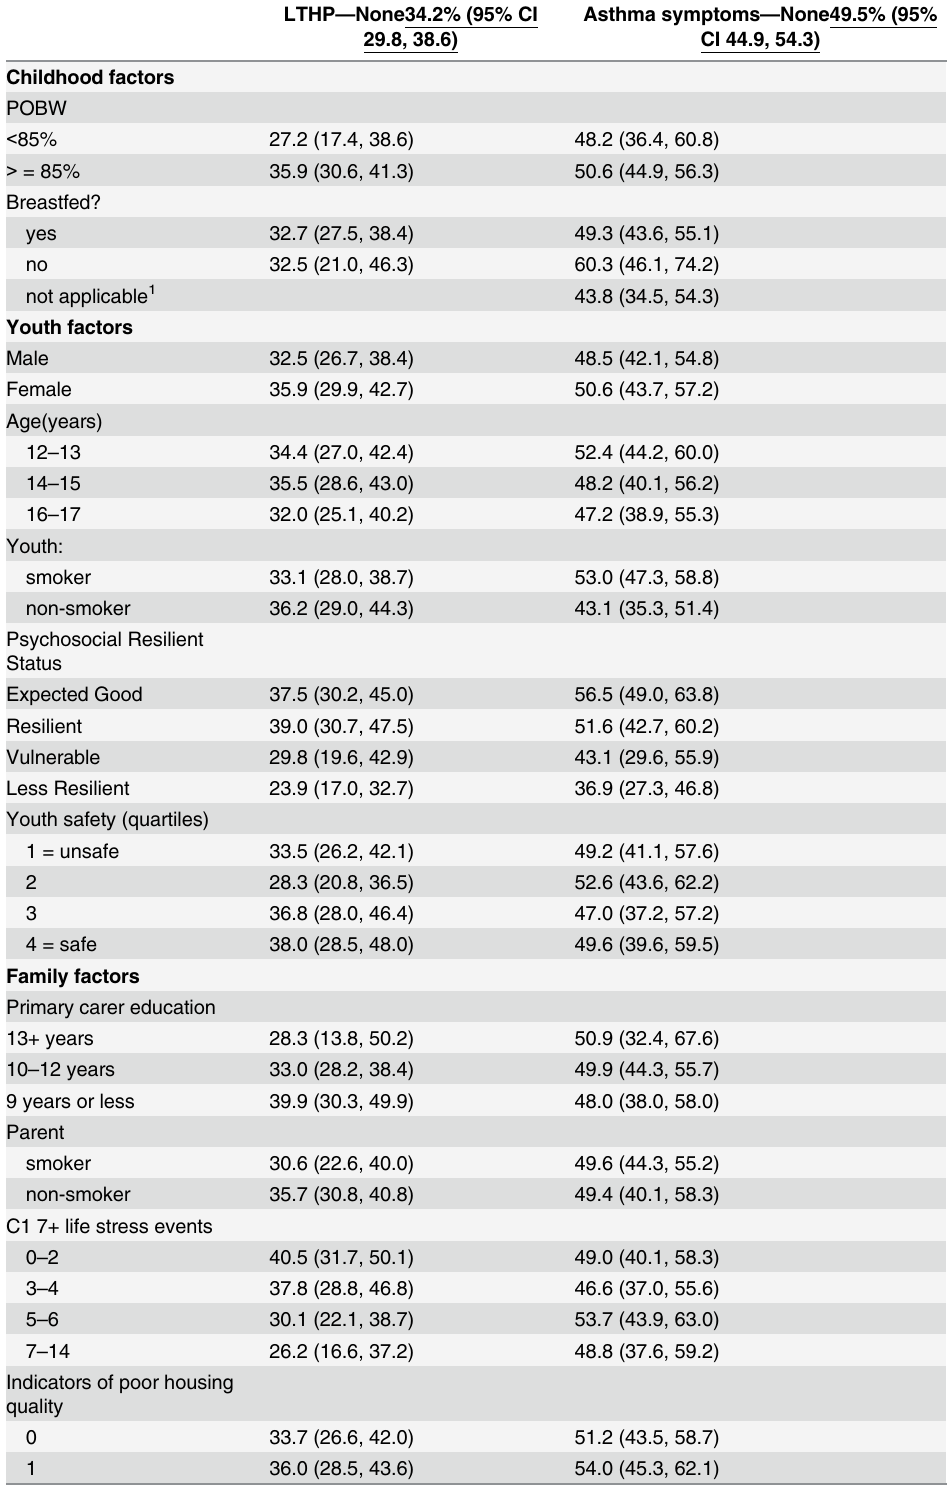
Table 2. Youth, family and neighborhood characteristics by lifetime health problems and asthma symptoms (n = 5180 95% CI 5130,